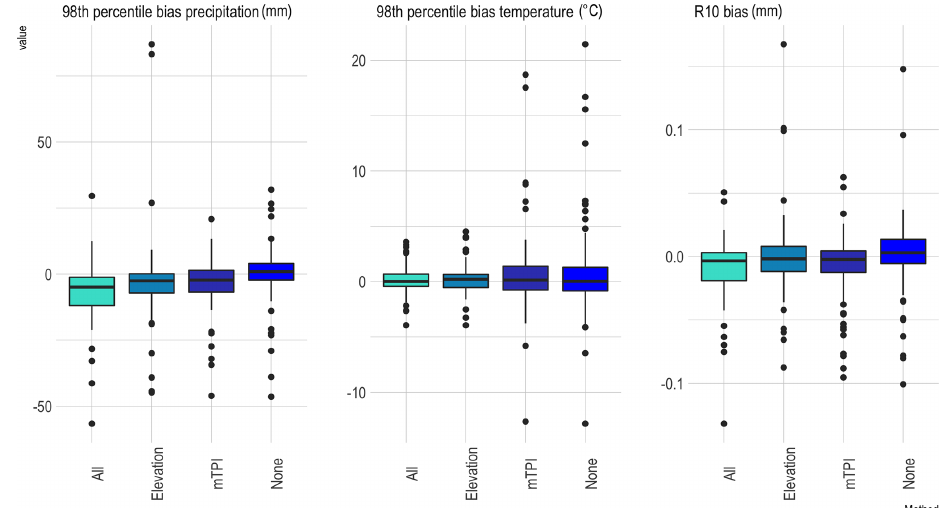
Figure 12. The same as Fig. 11 but for extreme